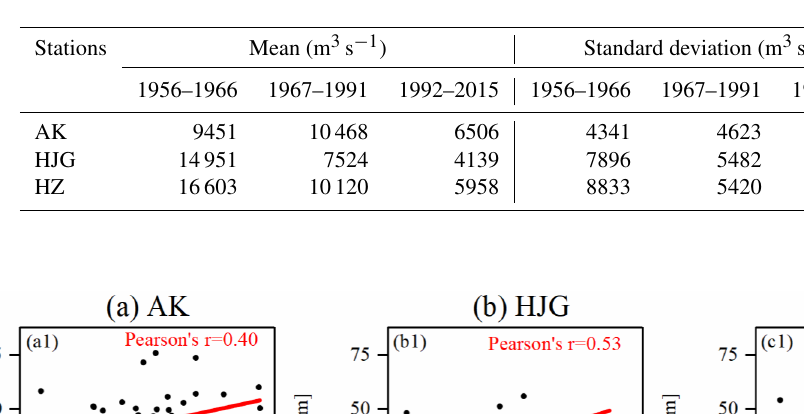
Table 4. Change in the mean and standard deviation of the AMDF after the construction of the two large reservoirs (Danjiangkou Reservoir, completed by 1967, and the Ankang Reservoir, finished by 1992).